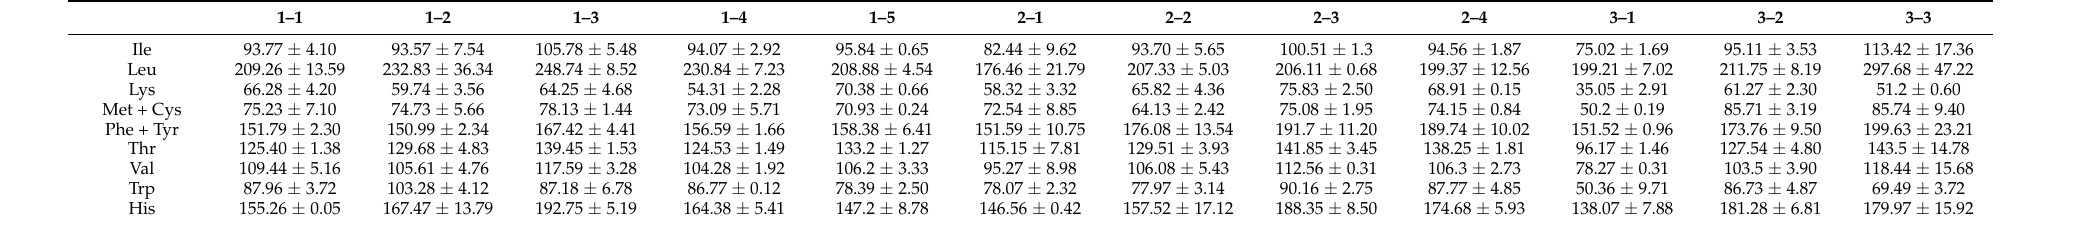
Table 9. PDCAAS of fresh corn from the three